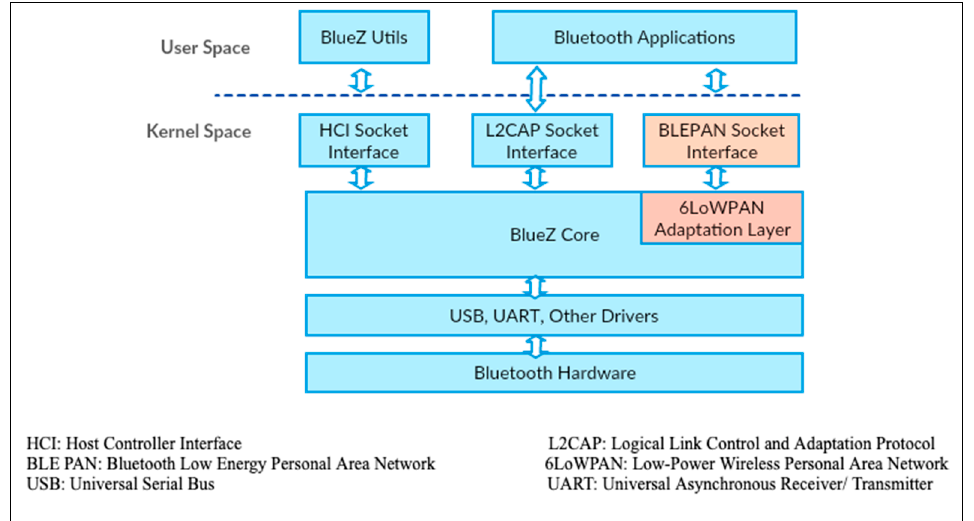
Figure 9. BlueZ stack